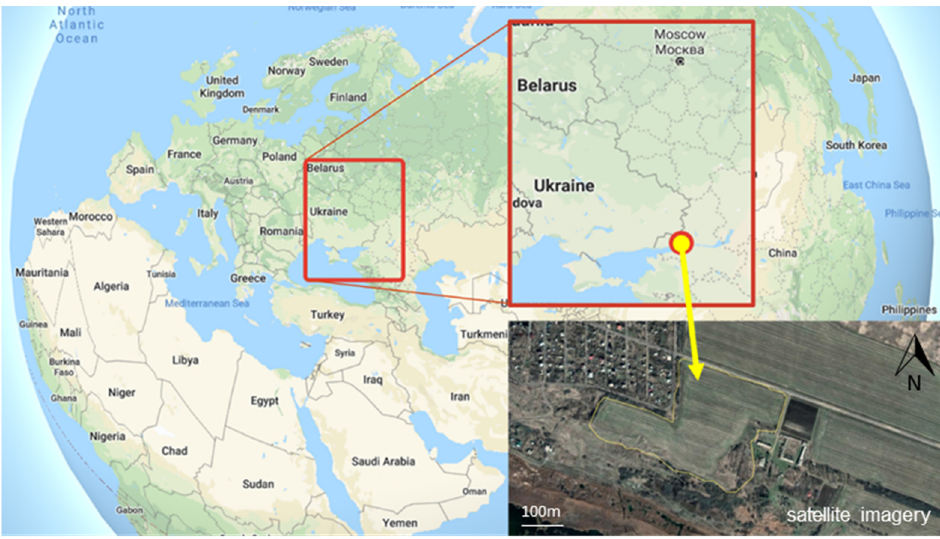
Figure 1. Location of the study site.